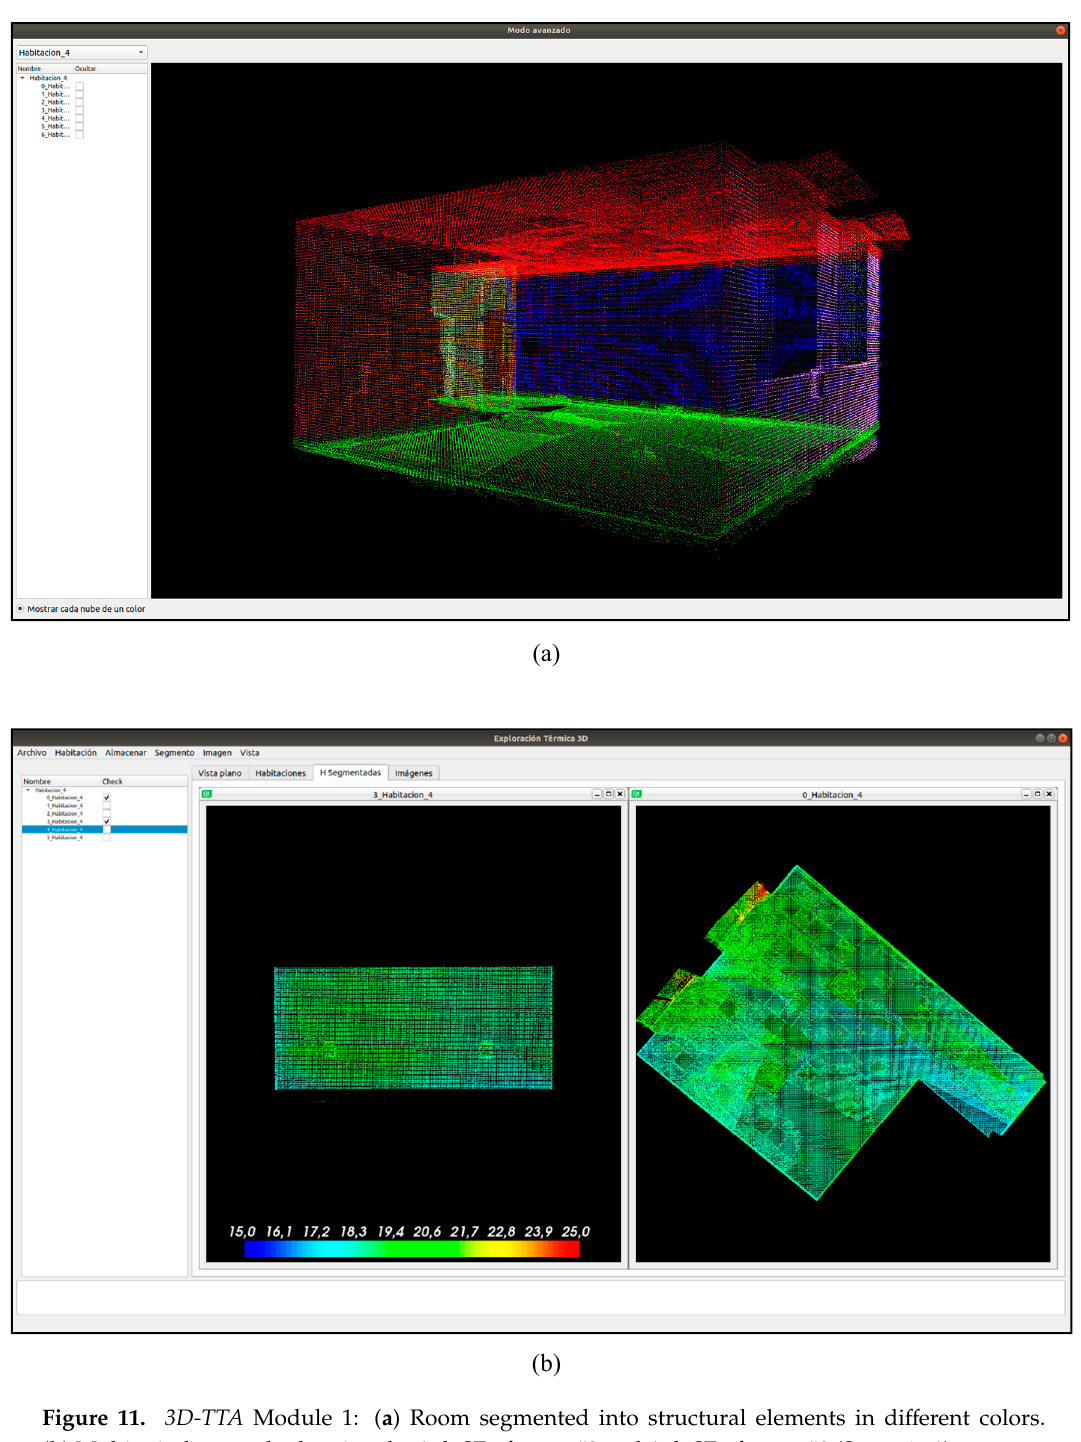
Figure 11. 3D-TTA Module 1: ( a ) Room segmented into structural elements in different colors. ( b ) Multi-window mode showing the 4-th SE of room #3 and 4-th SE of room #0 (Scenario 1).